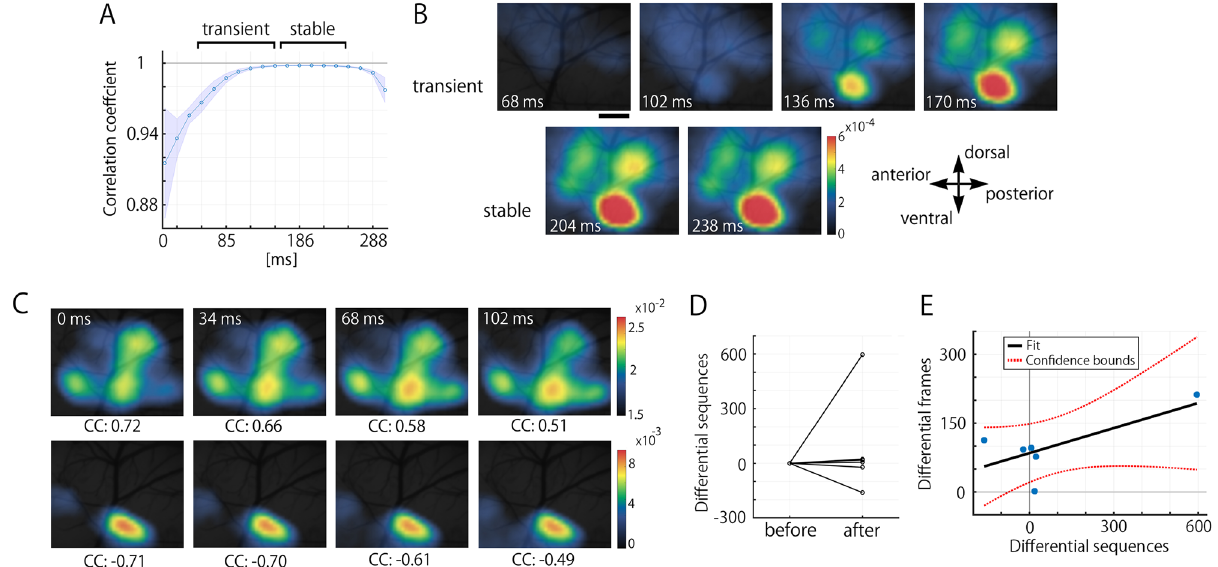
Figure 4. Detection of spontaneous cortical activities with a similar spatiotemporal pattern evoked by PDL stimulation. ( A ) A time course of three averaged consecutive spatial CCs. The SEM of the CC gradually decreased immediately after PDL stimulation (the transient period) and then reached the stable period. ( B ) A representative spatiotemporal sequential pattern responding to PDL stimulation in the transient (upper) and stable (bottom) periods. While the patterns gradually changed during the transient period, the stable period showed almost consistent spatial patterns. The scale bar indicates 500 µm. ( C ) Spontaneous sequential activities with a high CC (upper), i.e., high similarity to the activities evoked by PDL stimulation, and with a low CC (bottom), i.e., spontaneous IC activation without S1/S2 activities. ( D ) A comparison of the number of sequences with high similarity to the activities evoked by PDL stimulation, whose spatial correlation was over mean + 2 SD for prestimulus activities from 51 to 152 ms (the transient period), between the session before and after PDL stimulation. No significant difference was detected (Wilcoxon signed-rank test; p = 0.69). ( E ) Relationship between the spontaneously emerging IC activity (Differential frames) and evoked-like sequence